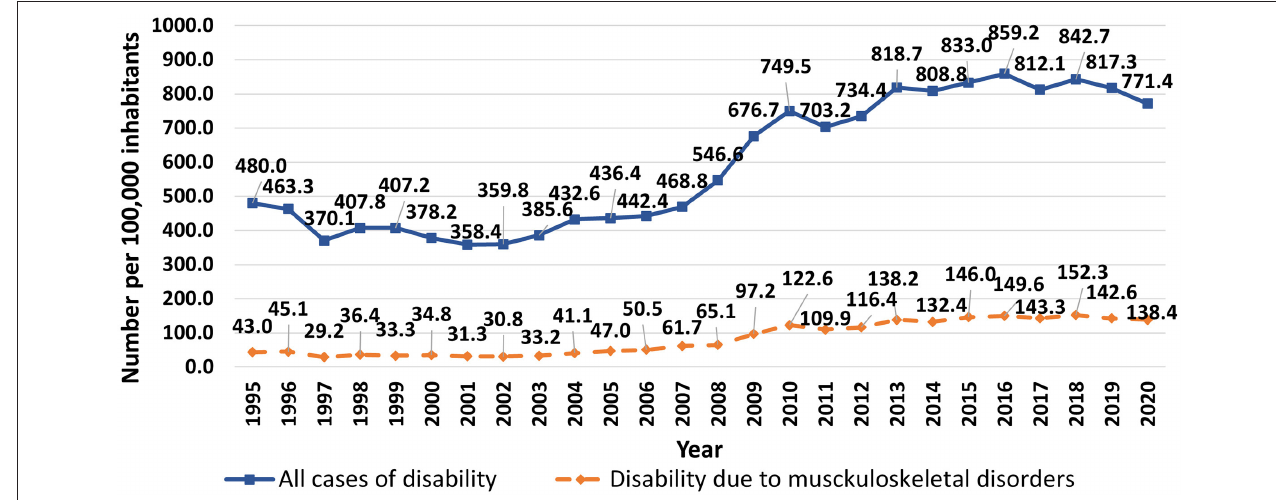
FIGURE 1 | Trends in first registered general disability in Latvia, 1995–2020 (total number of cases and cases caused by musculoskeletal diseases per 100,000 inhabitants).